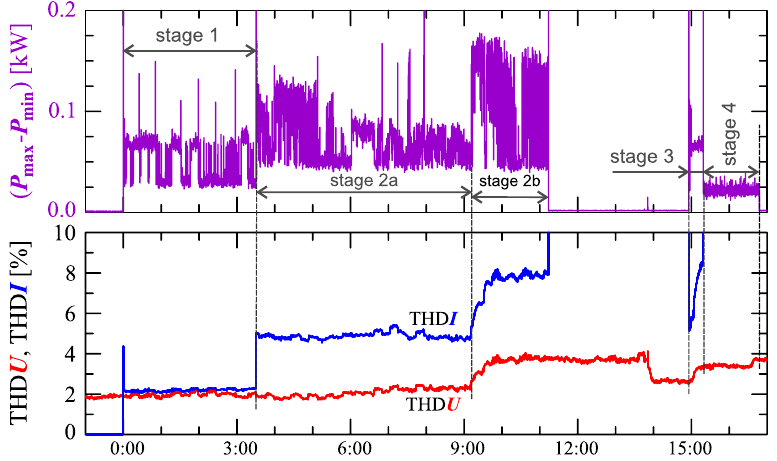
Figure 26. The characteristic of difference between the maximum and minimum active power ( P max − P ) = f ( t ) (top), and the characteristics of the voltage THD factor THD U = f ( t ) and min current THD factor THD I = f ( t ) (bottom) for Case III.